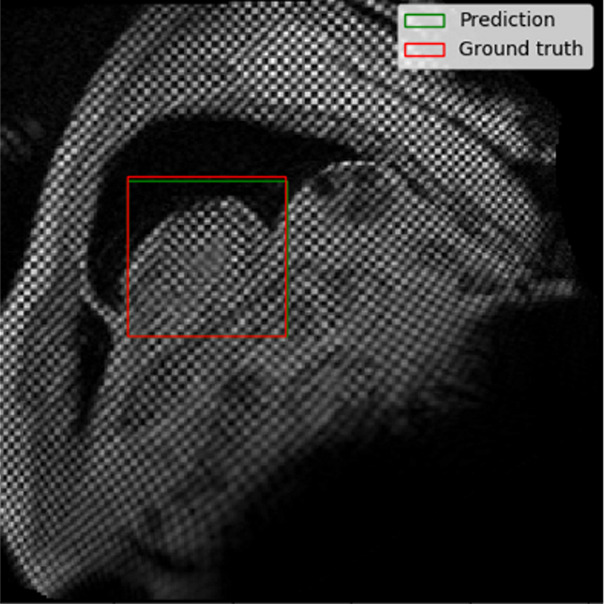
Example results from the localization network. (a) Intersection over union (IoU) of 53% and (b) IoU of 63% are the worst prediction results within the test set. (c, d) Typical prediction results. (e) Histogram shows the distribution of accuracy (IoU) throughout the test set.